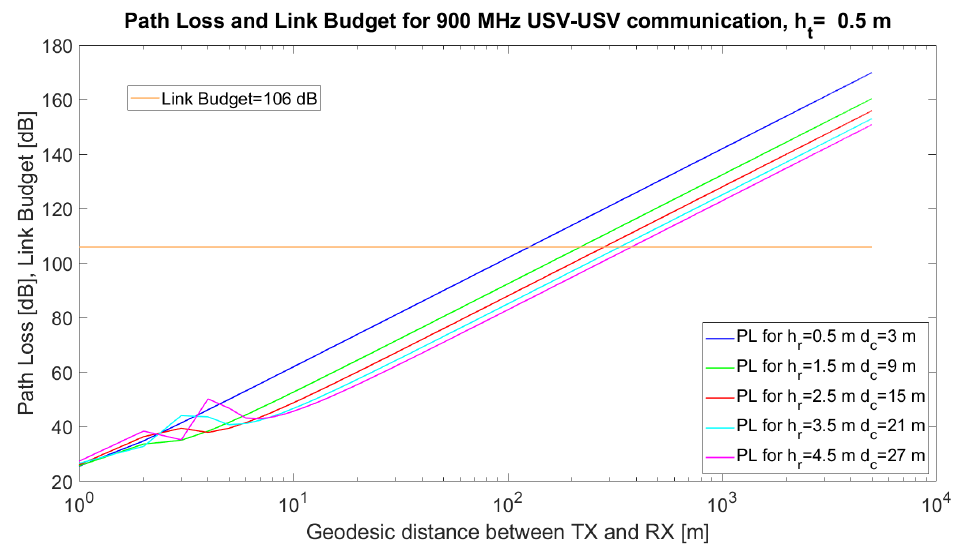
Figure 6. Path loss, link budget and critical distance for USV–USV link, when USV antenna height is h t = 0.5 m and the solution in [57] is